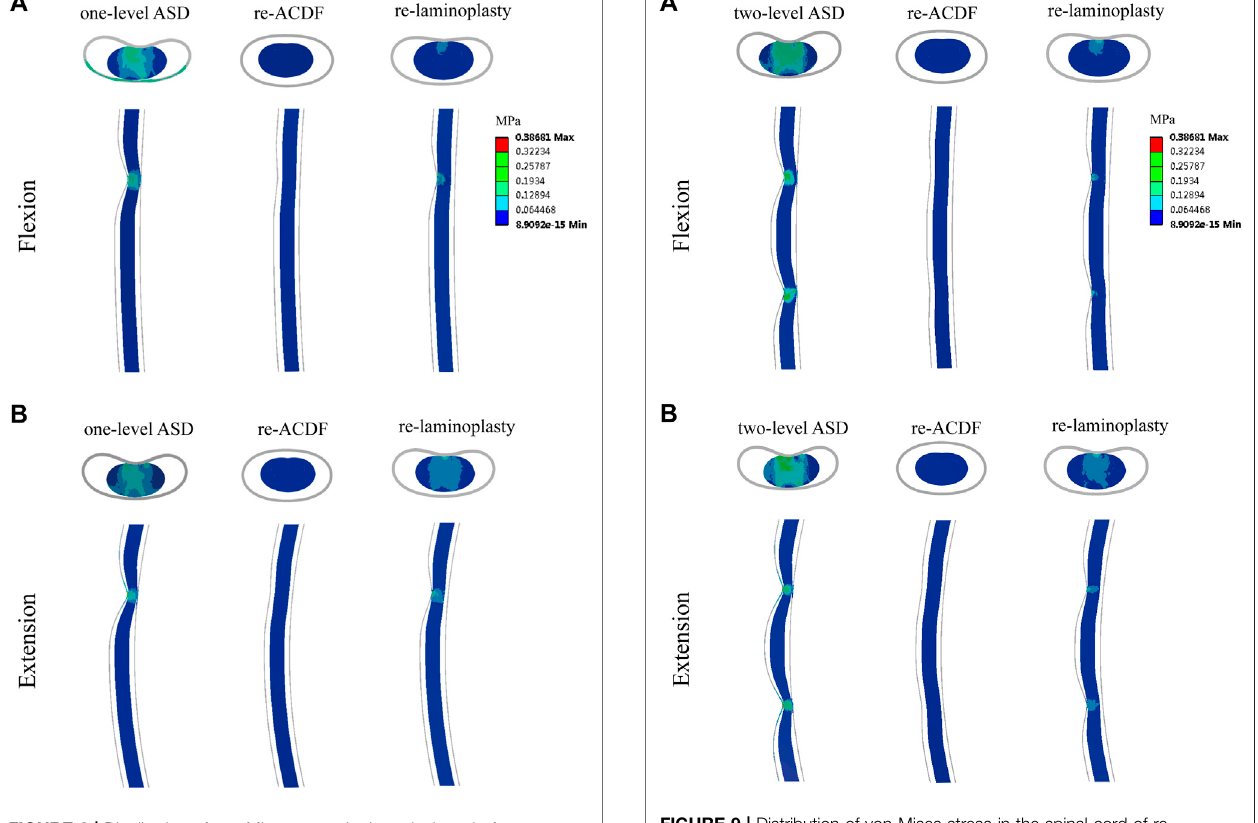
FIGURE 8 | Distribution of von-Mises stress in the spinal cord of re- ACDF and re-laminoplasty models for the treatment of one-level ASD. (A) Stress distribution in fl exion. (B) Stress distribution in extension.